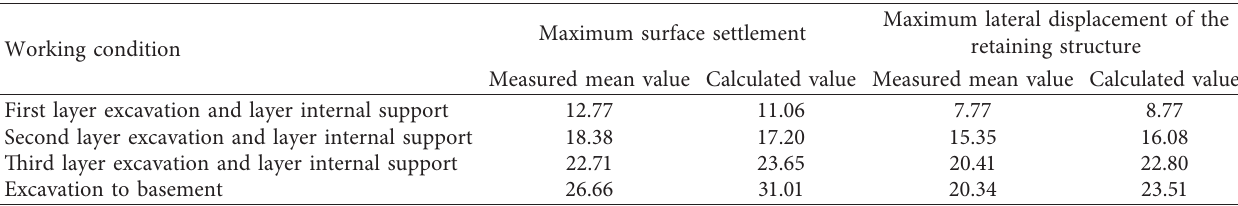
Figure 2: Surface settlement and lateral wall displacement of each excavated condition of the subway station foundation pit. Table 5: Deformation comparison between analytical and measured